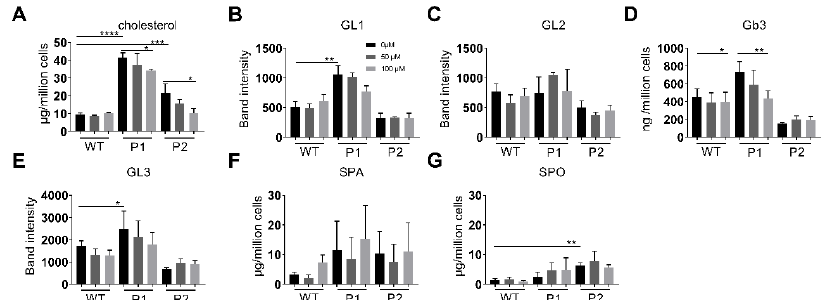
Figure 6. Lipid analysis from total cell lysates upon treatment with 50 and 100 μM NB-DNJ. Cholesterol and glycolipid analysis was performed by HPLC and TLC, respectively. Cholesterol ( A ), GL (Glycolipid, B , C and E ), Gb3 (Globotriaosylceramide, D ), SPA (Sphinganine, F ), SPO (Sphingosine, G ). Each bar equates to at least three repetitions, with the WT corresponding to the average of three repetitions of three WT fibroblasts from independent healthy donors. P1: I1061T/P887L, P2: D874V/D948Y. SEM, Student’s t -test * p ≤ 0.05, ** p ≤ 0.01, *** p ≤ 0.001, **** p ≤